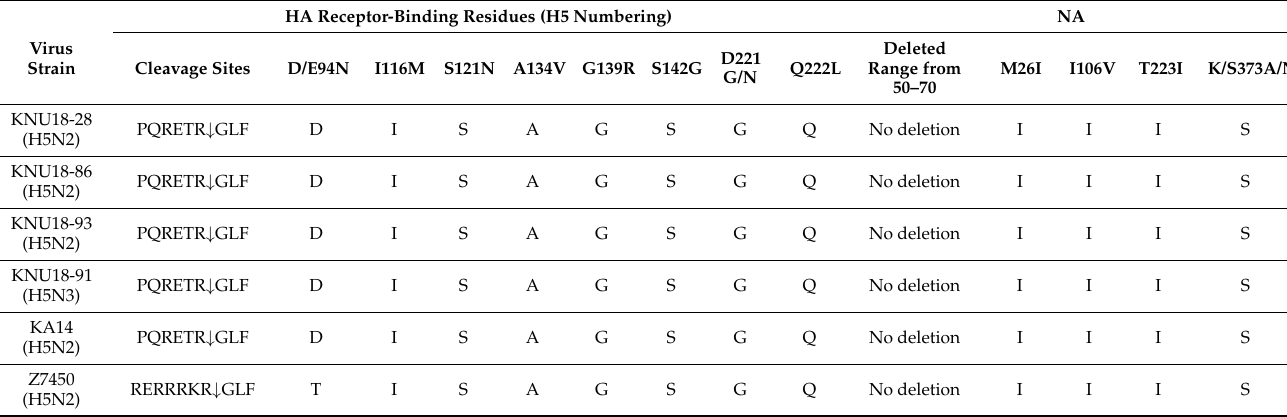
Table 4. Comparison between the hemagglutinin (HA) receptor-binding sites and neuraminidase (NA) of the three novel avian influenza H5N2 viruses and those of low pathogenic and highly pathogenic H5 viruses. HA Receptor-Binding Residues (H5 Numbering) NA Virus Strain